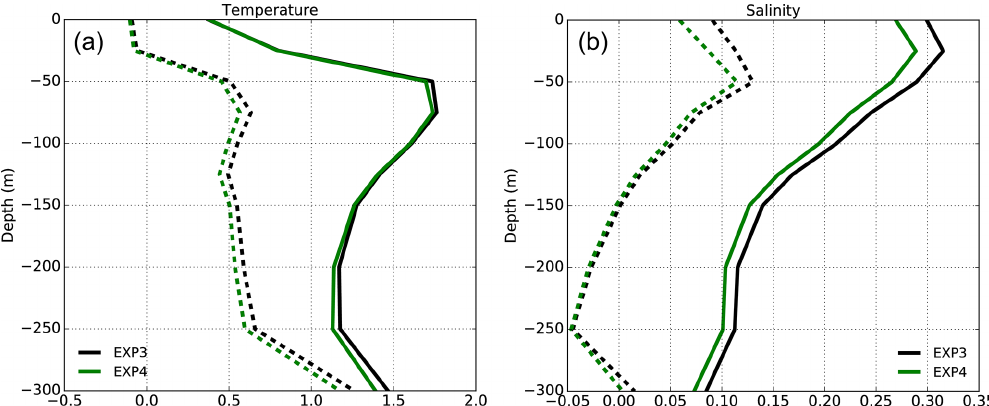
Figure 6. Profiles of model bias (dashed lines) and RMSE (solid lines) for (a) temperature (K) and (b) salinity (psu) for the upper 300m. Statistics are calculated using the misfit of the model background value from (black) EXP3 and (red) EXP4 with respect to CTD profiles in the Barents Sea and for September 2009.